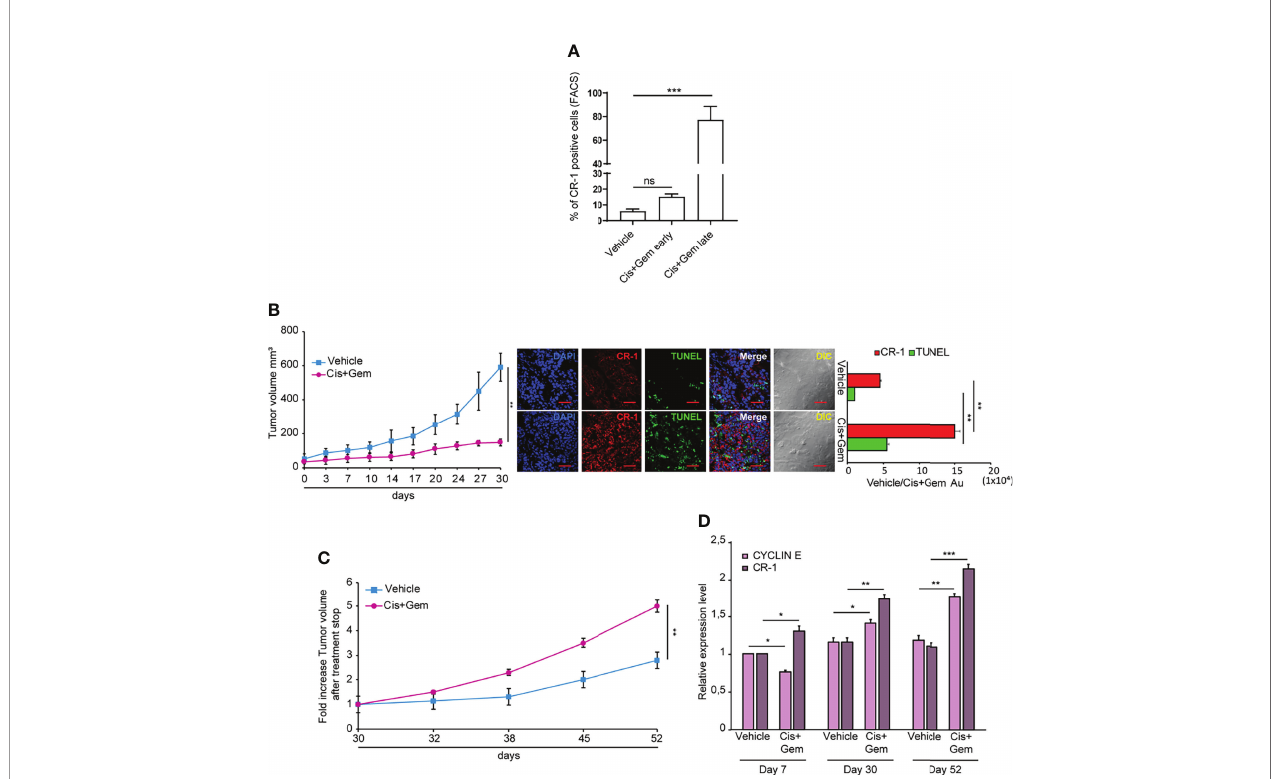
FIGURE 4 | Chemotherapy treatment increases CRIPTO (CR-1) expression and tumor progression in NSCLC xenografts. (A) Flow cytometry analysis of CRIPTO on SCC1 cells treated with vehicle only (Vehicle) or with chemotherapeutic agents (Cis+Gem early and Cis+Gem late). Cells in the Cis+Gem samples were treated with Cisplatin 5 m M plus Gemcitabine 25 m M for 4 days then washed, replated and analyzed after 3 additional days (Cis+Gem early) or 7 additional days (Cis+Gem late). The graph shows the mean ±SD of two independent experiments. Ns, non-signi fi cant, ***P < 0.001. (B) Left: Xenograft volume of SCC1 spheroids cells treated with Vehicle (Vehicle, light blue square) or with Cisplatin plus Gemcitabine (Cis+Gem, Dark pink dots). Mean±SEM, 6 mice/group. **P<0.01 (two-tailed t test). Middle: representative confocal images of CRIPTO (red) and TUNEL (green) staining of Vehicle and Cis+Gem treated tumors. 40X magni fi cation, scale bar 50 m m. Right: quanti fi cation of CRIPTO and TUNEL performed on 3 sets composed of 5 fi elds/group. **P<0.01. AU, arbitrary units. (C) Tumor variation after treatment withdrawal of SCC1 spheroids treated with vehicle (Vehicle, light blue square), and Cis plus Gemcitabine (Cis+Gem, dark pink dots). Mean±SEM, 4 mice/group. (D) qRT-PCR analysis of CRIPTO and Cyclin E mRNA expression of SCC1-derived xenografts, monitored during treatment and after treatment withdrawal at the indicated times. *P < 0.05; **P < 0.01, ***P <